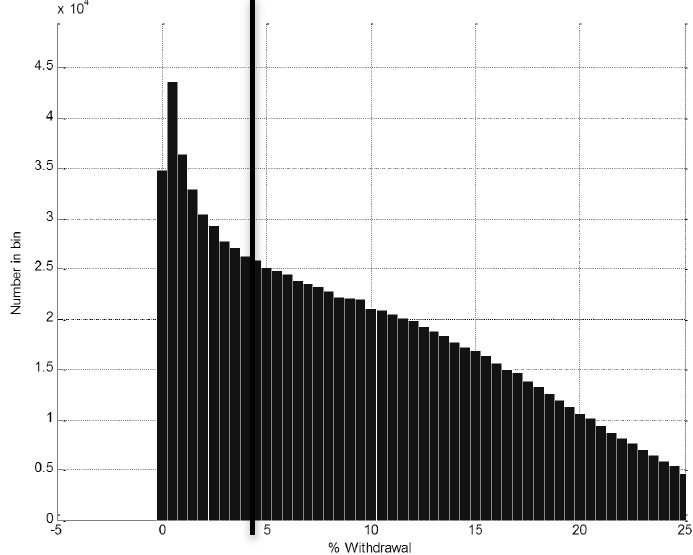
FIGURE 7: Failure rates for high-risk portfolio Source: